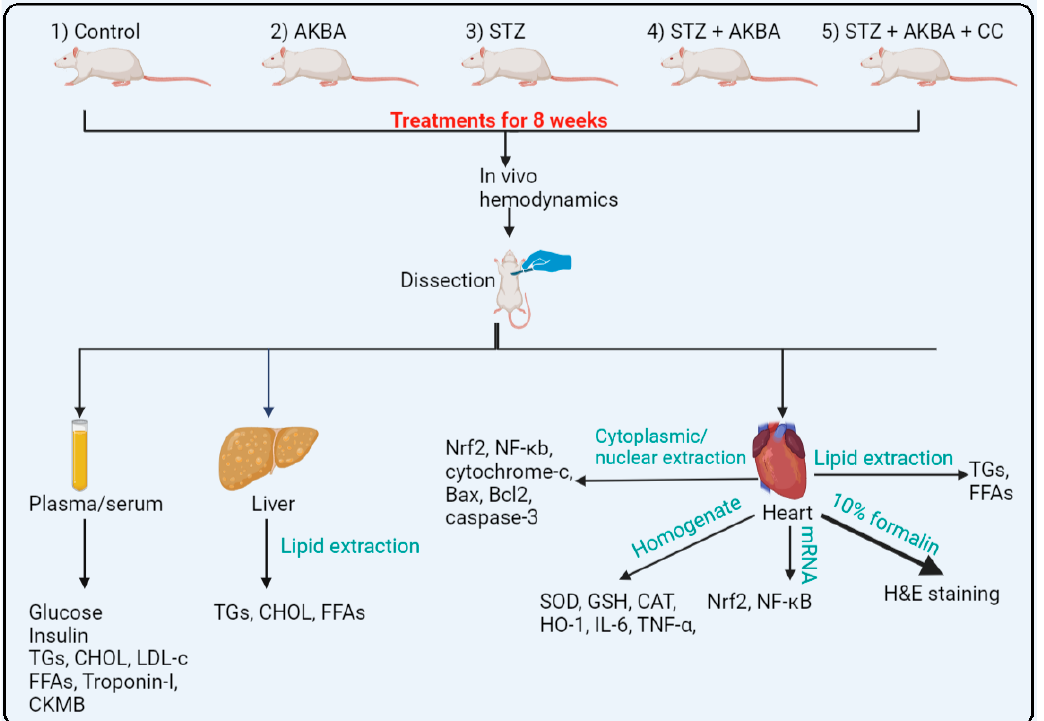
Figure 1. The e xperimental design used in the study. Figure 1. The experimental design used in the